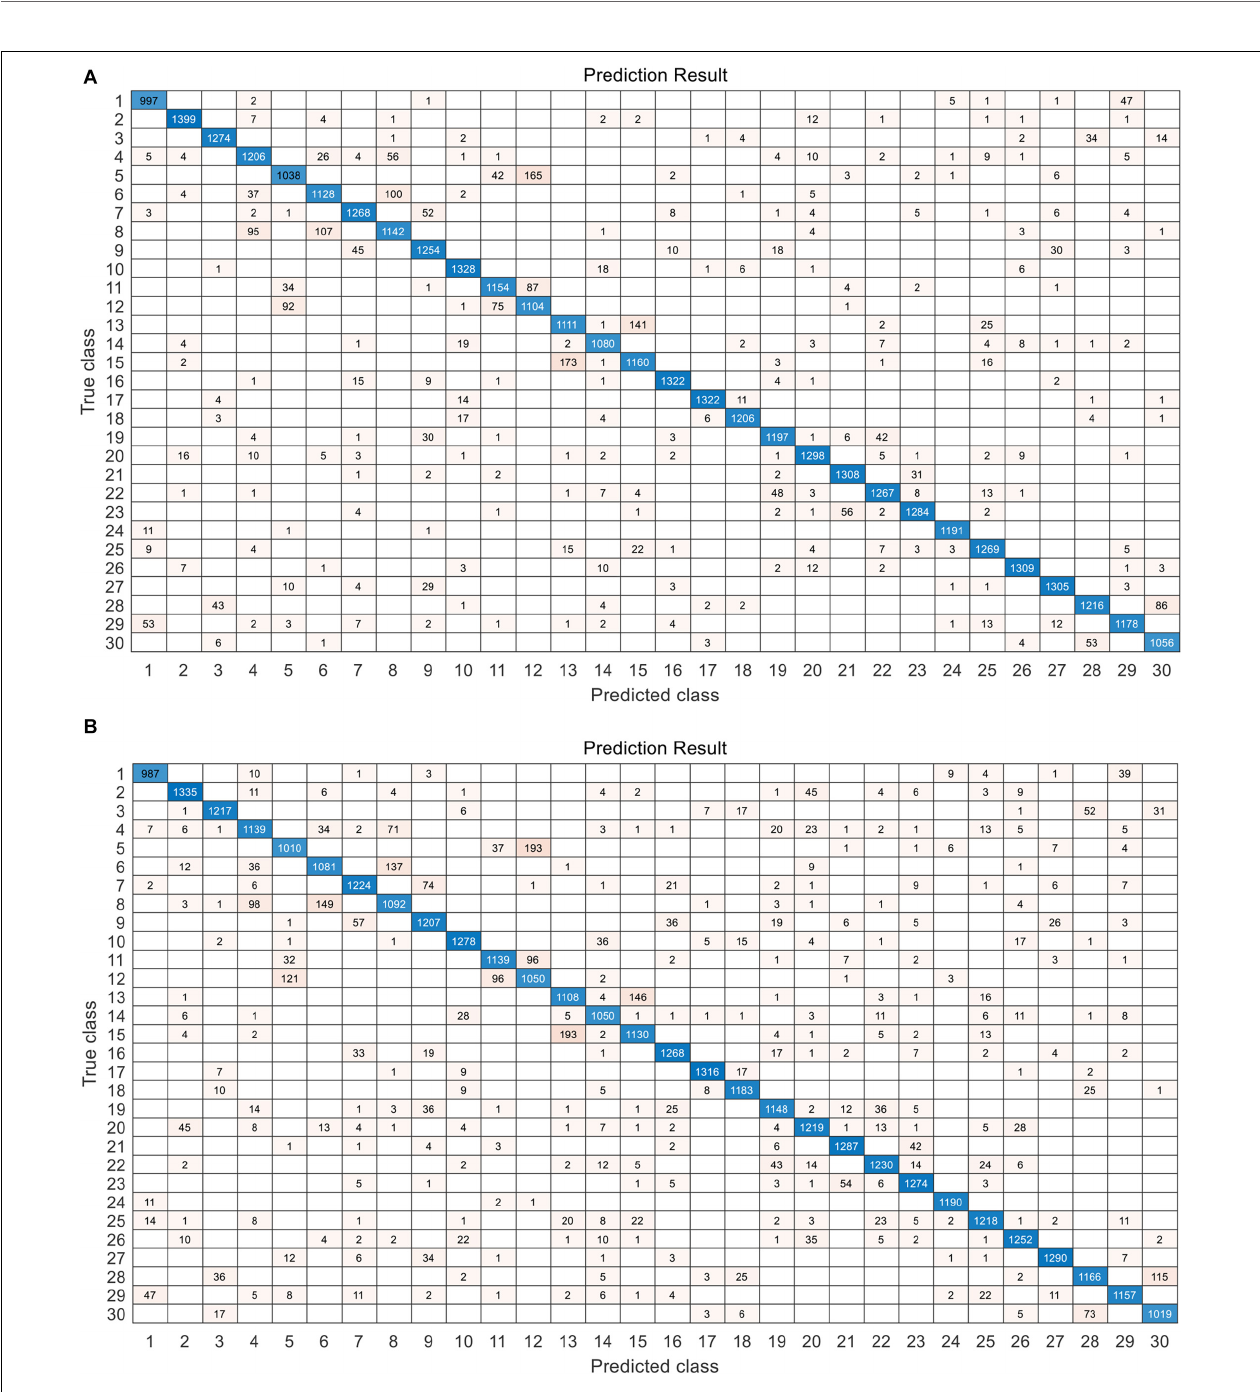
FIGURE 7 | The confusion map of the best classification result on the prediction set. (A) The result achieved by CNN with attention (CNN-ATT) model with 200 features. (B) The result achieved by CNN-ATT model with 60 features selected by